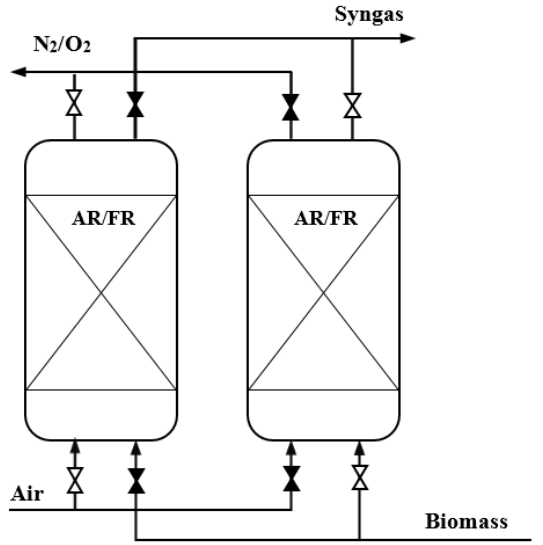
Figure 6. Simple configuration of alternating packed or fluidized bed reactors